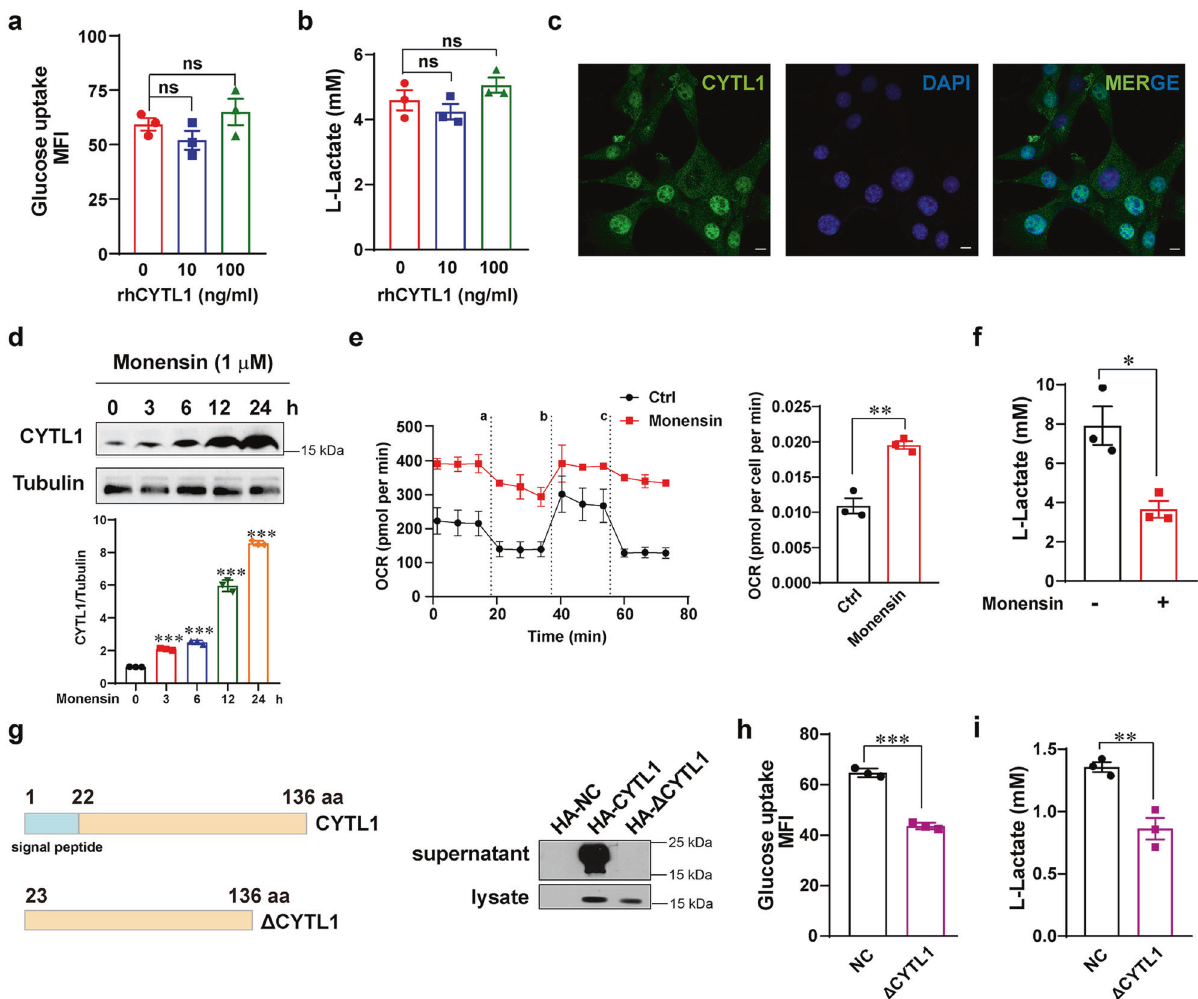
Fig. 2 Intracellular CYTL1 inhibits glycolysis in breast cancer. a Glucose-uptake activity and b lactate production levels in MDA-MB-231 cells after treatment with rhCYTL1 at the indicated concentrations for 48 h. ns no signi fi cant. c The subcellular location of CYTL1 was analyzed by immuno fl uorescence in MDA-MB-231 cells. Representative data are shown from three independent experiments. Scale bar, 5 μ m. d The amount of CYTL1 was determined by western blot in MDA-MB-231 cells after treatment with monensin for the indicated period. Tubulin was used as a loading control. e The OCR and f lactate production levels in MDA-MB-231 cells after treatment with 1 μ M monensin for 24 h. g The supernatants and cell lysates from MDA-MB-231 cells transfected with HA-tagged CYTL1 or Δ CYTL1 expressing plasmids were determined by western blot using an anti-HA antibody. Right panel: schematic representation of the full-length CYTL1 and Δ CYTL1 plasmids. h Glucose- uptake activity and i lactate production levels in MDA-MB-231 cells overexpressing Δ CYTL1. The data are shown as the mean ± SD of three independent experiments. * P < 0.05, ** P < 0.01, *** P <